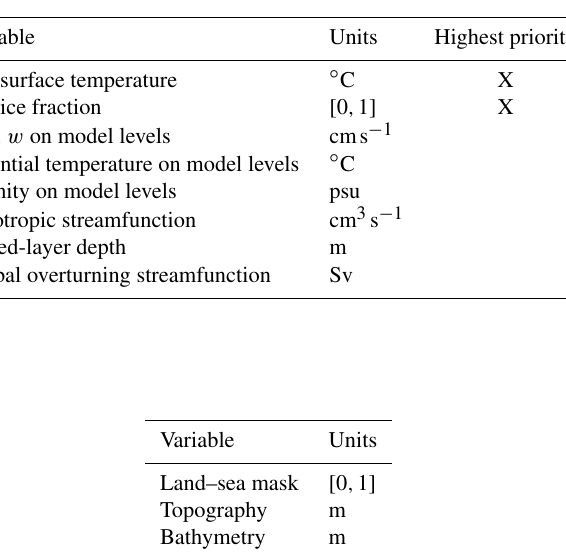
Table A2. Ocean variables.